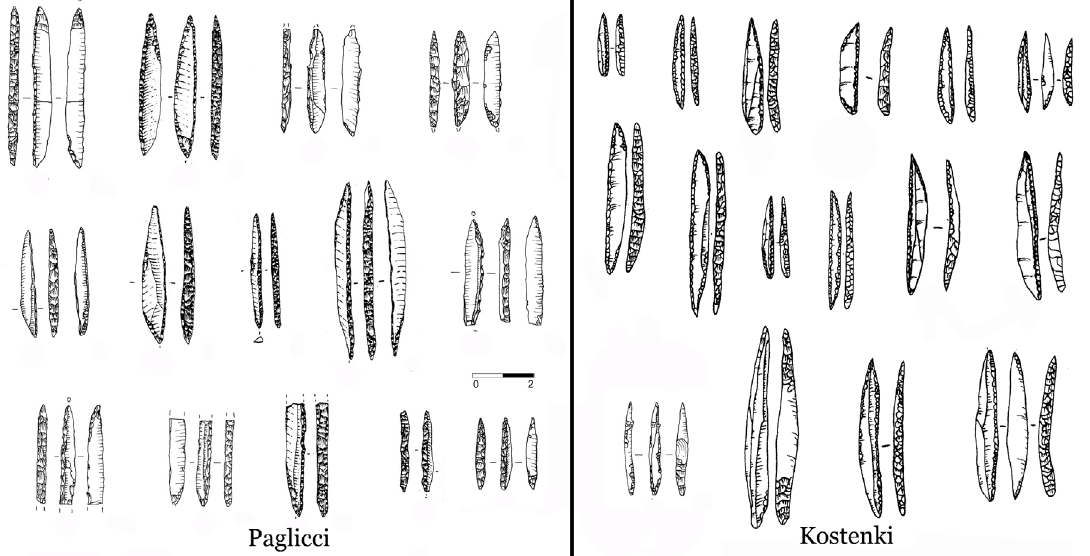
Figure 7. Backed points of Paglicci (Palma di Cesnola, 2005) and Kostenki 8 (Sinitsyn, 2015). As for microwear, some polish has been detected on the materials from Paglicci; while the tools of Kostenki have not been analysed, but in both cases the conservation of the materials all together in small bags prevents us from considering any polish with